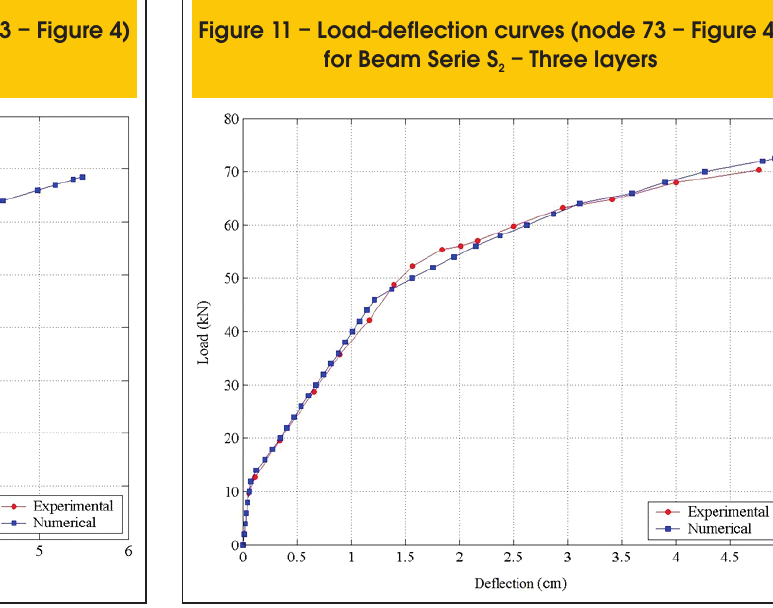
Figure 9 – Load-deflection curves (node 73 – Figure 4) for Beam Serie S – Two layers 2